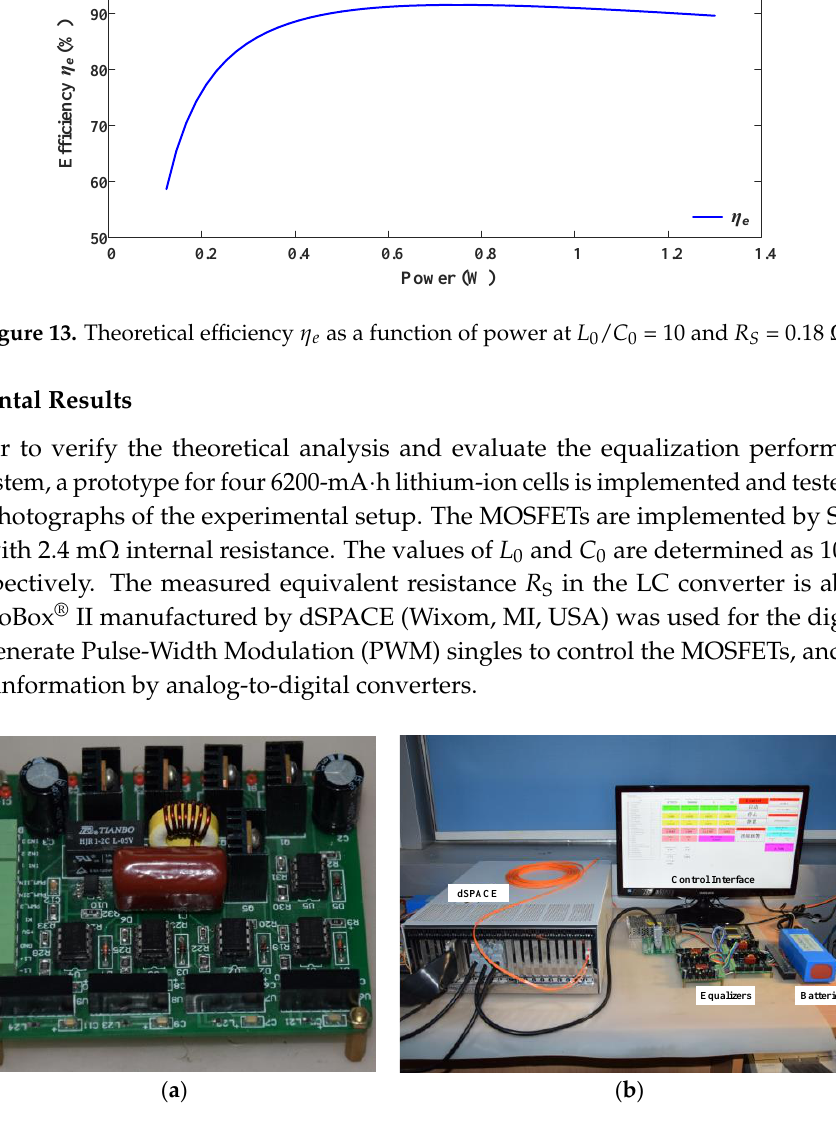
Figure 12. Theoretical efficiency η e as a function of L 0 / C 0 ratio with different R S .